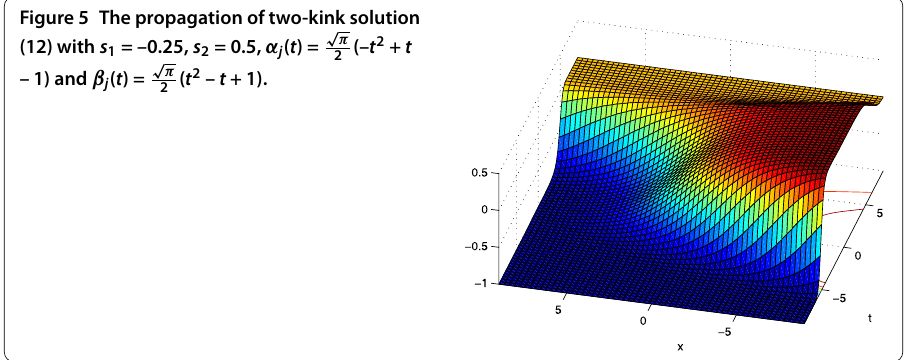
Figure 5 The propagation of two-kink